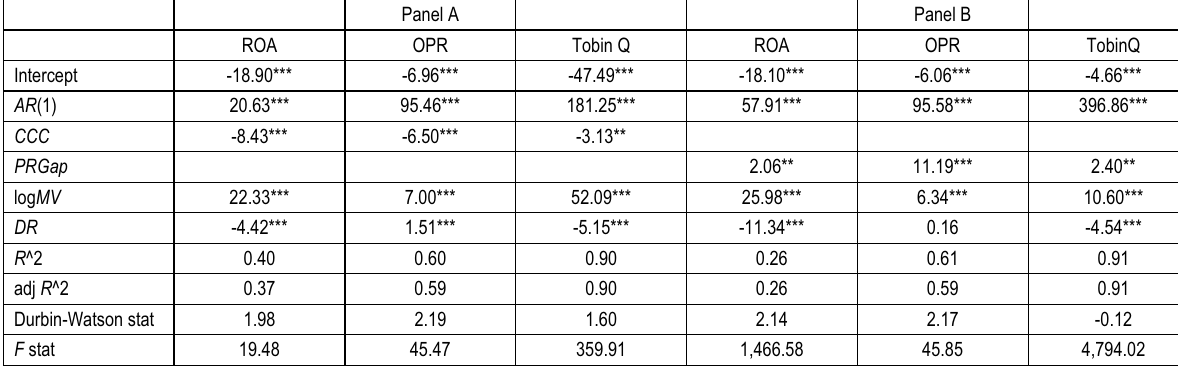
Table 8. Regression results of all